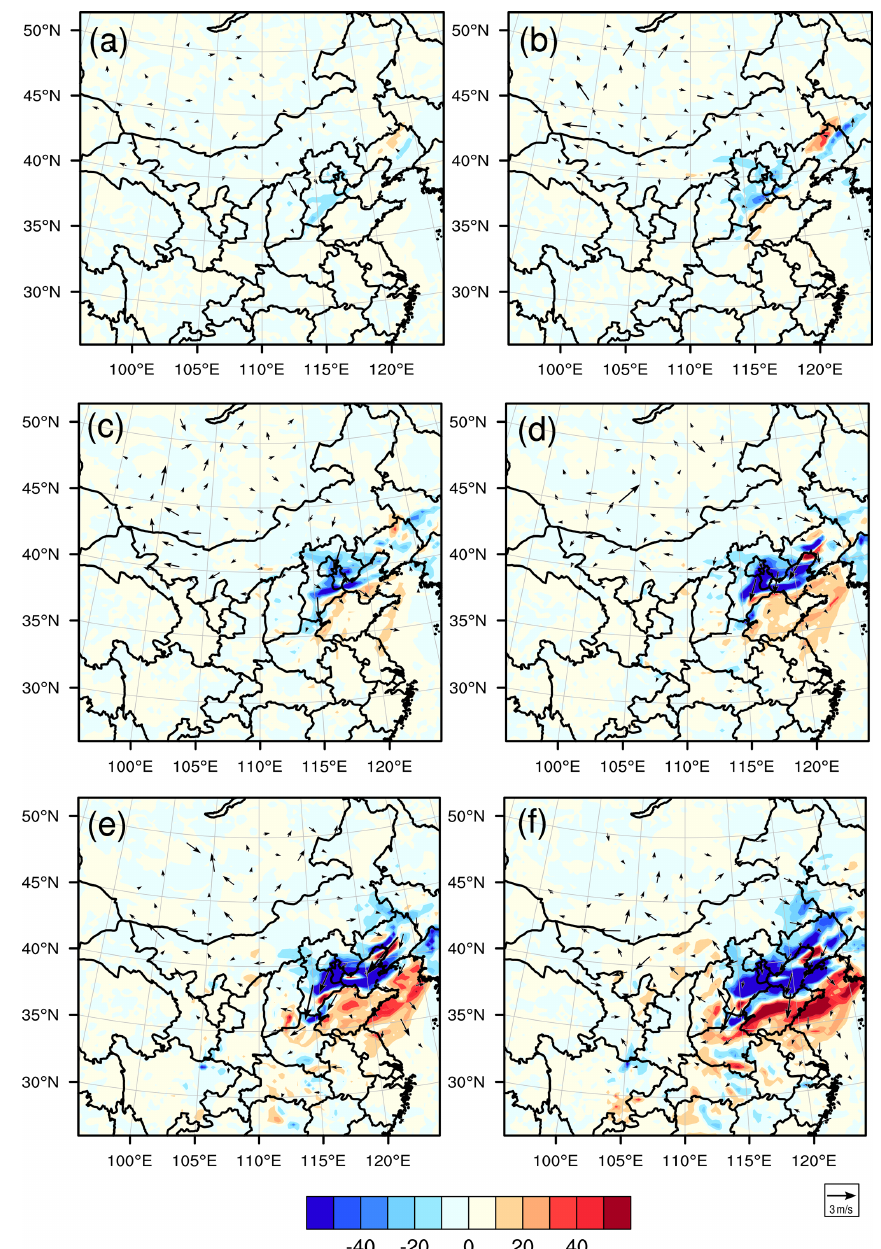
Figure 13. The same as Fig. 12 but for the forecast starting from 14:00BJT on 2